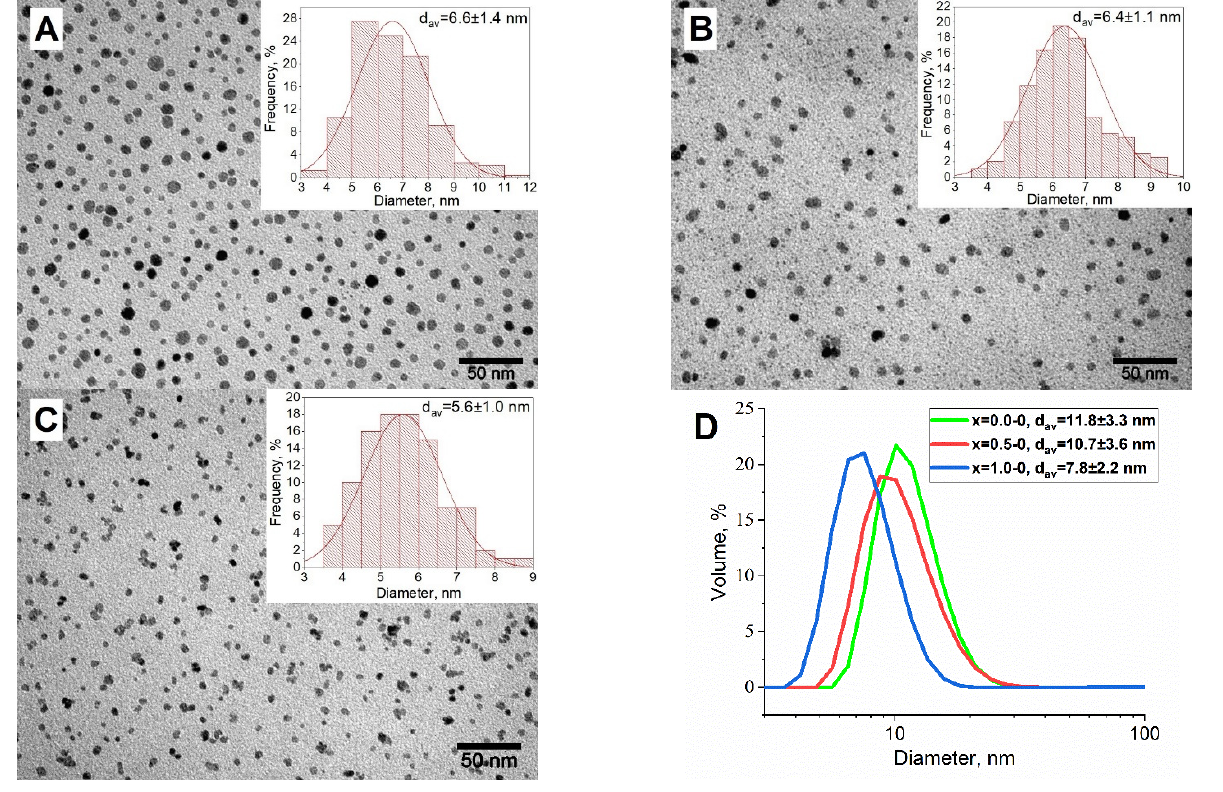
Figure 1. TEM-images and distribution by size for the seed MNP of x = 0.0-0 ( A ); x = 0.5-0 ( B ); x = 1.0-0 ( C ) and their hydrodynamic sizes measurements ( D ).